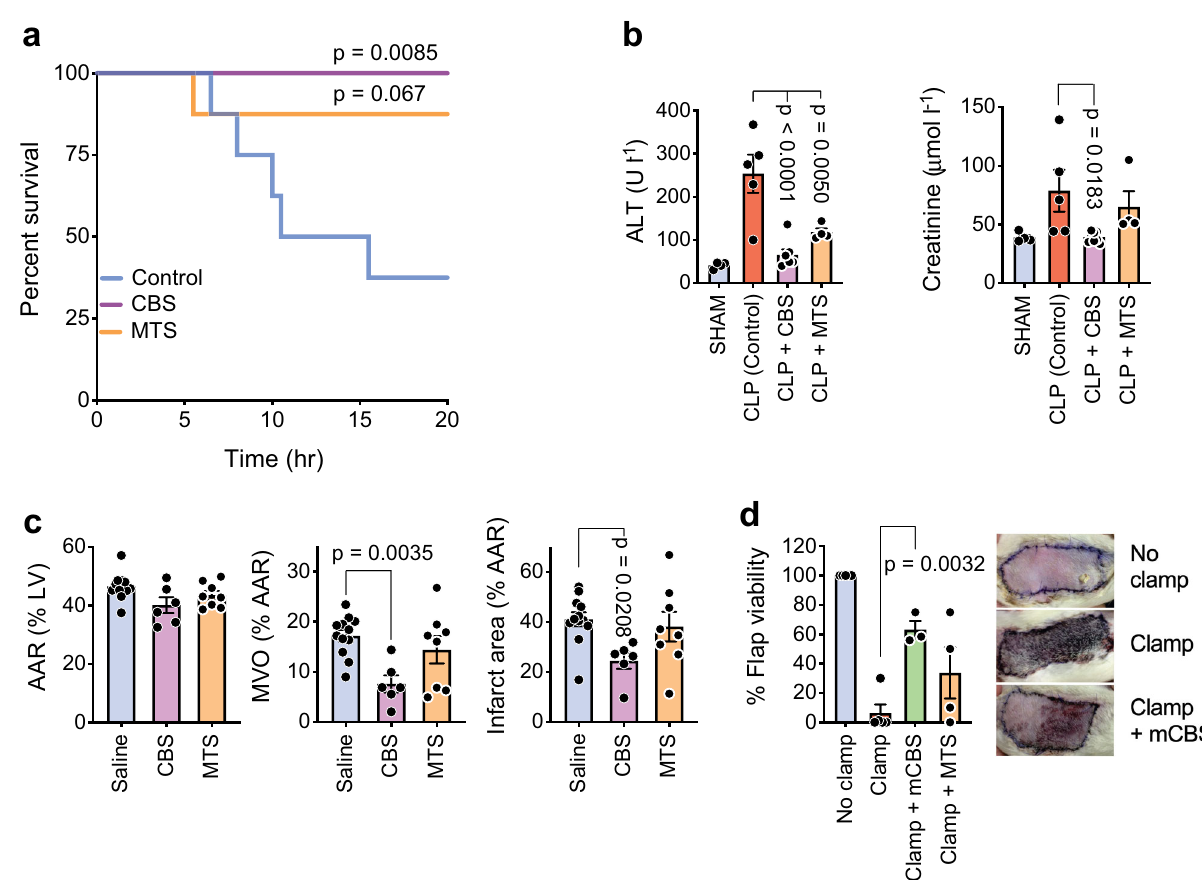
Fig. 6 SPAs inhibit a range of pathologies involving extracellular histones. a Survival of rats ( n = 8 per group) subjected to cecal ligation and puncture (CLP) and receiving saline (Control), CBS, or MTS. P values obtained with survival analysis log-rank (Mantel – Cox) test. b Kidney and liver damage in CLP rats, as measured by ALT and creatinine blood levels ( n = 4 – 8/group, blood could not be collected or was clotted from some rats). c Effect of CBS and MTS ( n = 6 – 12/group) on cardiac IRI in rats, with the area at risk (AAR) in left ventricle (LV), microvascular obstruction (MVO), and infarct area being measured. d Effect of mCBS and MTS on a skin fl ap model of IRI in rats ( n = 3 – 5/group), with representative photos shown (skin fl ap reduced to 25% normal size). Data are presented as mean ± s.e.m. and analyzed by one-way ANOVA with Dunnett ’ s correction for multiple comparisons. Source data are provided as a Source Data